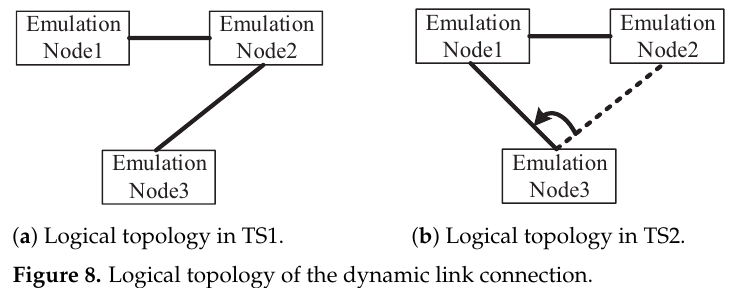
Figure 8. Logical topology of the dynamic link connection.